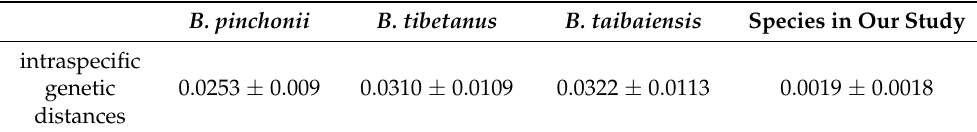
Table 4. The intraspecific genetic distances of each Batrachuperus